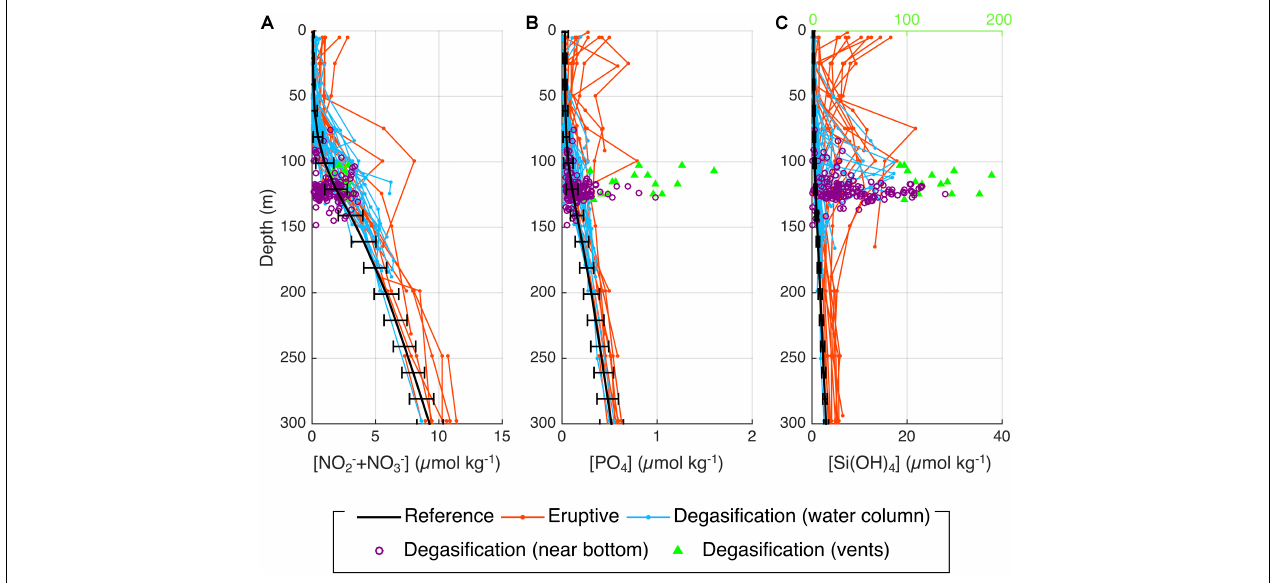
FIGURE 2 | Vertical profiles of (A) nitrate, (B) phosphate, and (C) silicate, for all the stations affected by the volcano, discerning the different stages and sampling methodologies. Black lines show the average concentrations from all the reference stations, with standard deviation. Upper x -axis in panel (C) corresponds to silicate concentration in the vent samples